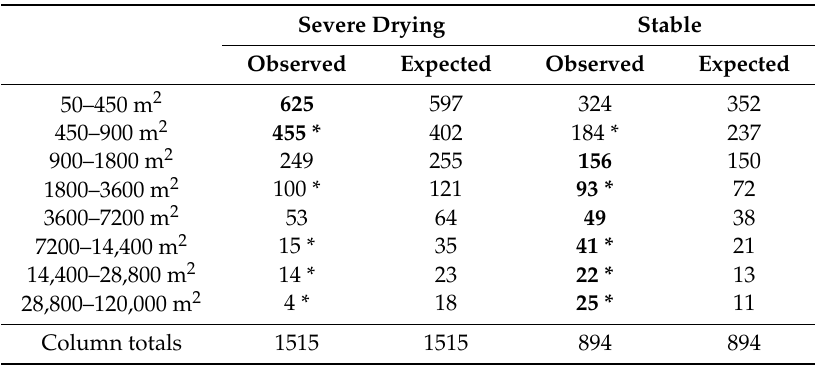
Table 2. Observed and expected size class distributions of waterbodies in severe drying and stable plots, based on the chi-square analysis. Bold numbers indicate that the number of observed waterbodies exceeds the number of expected waterbodies. Numbers with an asterisk indicate a significant difference from the expected value, using a Bonferroni correction ( p < 0.0063).